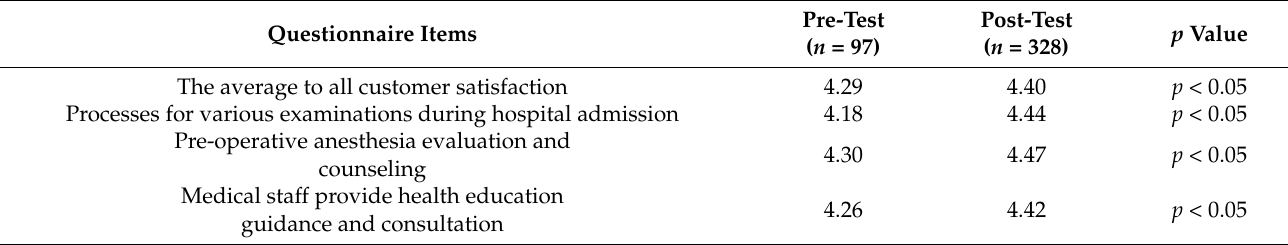
Table 8. Analysis of the Level of Satisfaction.